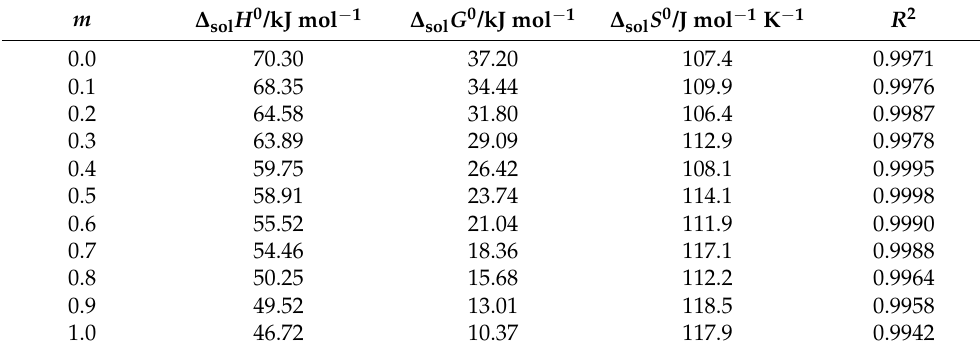
Table 10. Apparent thermodynamic parameters ( ∆ sol H 0 , ∆ sol G 0 , and ∆ sol S 0 ) along with R 2 values